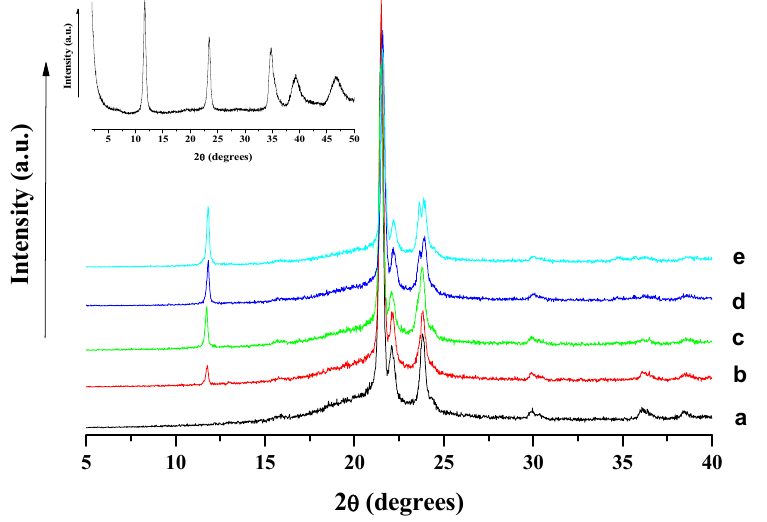
Figure 2. XRD spectra of: PCL ( a ); PCL/1% LDH-EHT ( b ); PCL/3% LDH-EHT ( c ); PCL/5% LDH-EHT ( d ); and PCL/7% LDH-EHT ( e ). Inset reports the XRD spectrum of LDH-EHT.